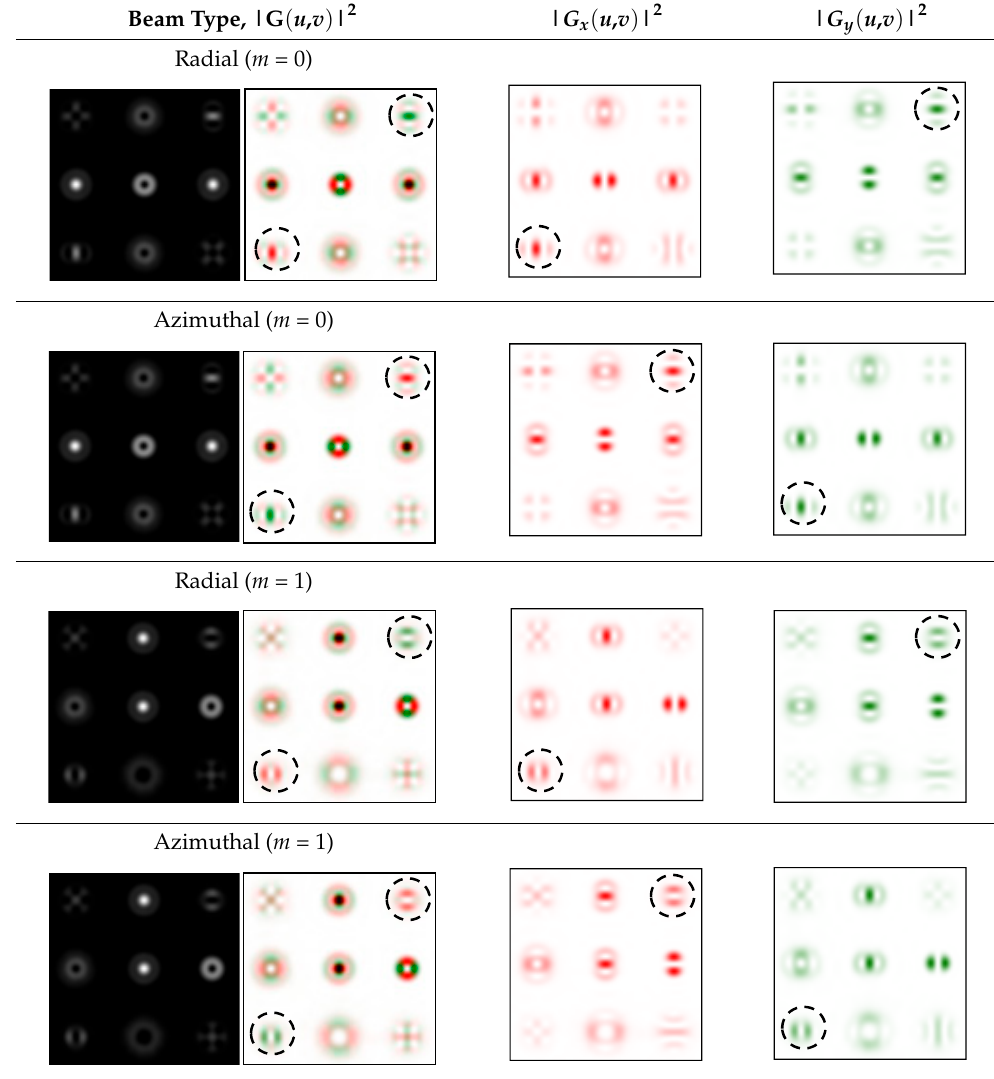
Table 5. Field distribution in the focal plane for cylindrically polarized beams of the first order ( p = 1) when using a filter with a superposition of optical vortices. Beam Type,